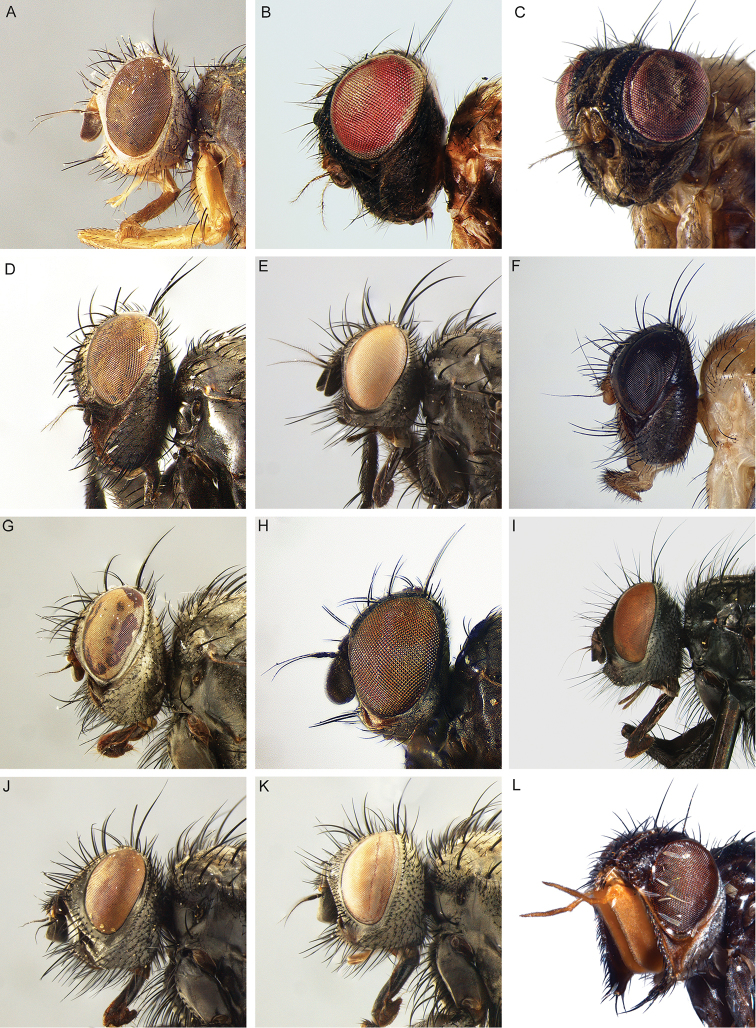
Rhinophoridae, head in lateral view. AMacrotarsina
longimana ♂ (Italy) B, CMelanophora
basilewskyi ♂ (Kenya) B lateral view C fronto-lateral view DMelanophora
roralis ♂ (Italy) EOplisa
tergestina ♂ (Italy) FParazamimus
congolensis ♂ (Burundi) GPaykullia
cf.
nubilipennis ♂ (Italy) HRhinodonia
antiqua ♂ (New Caledonia) [holotype] IRhinomorinia
sarcophagina ♂ (Italy) JStevenia
palermitana ♂ (Italy) [paratype] KTricogena
rubricosa ♂ (Morocco) LShannoniella
setinervis ♂ (Brazil).